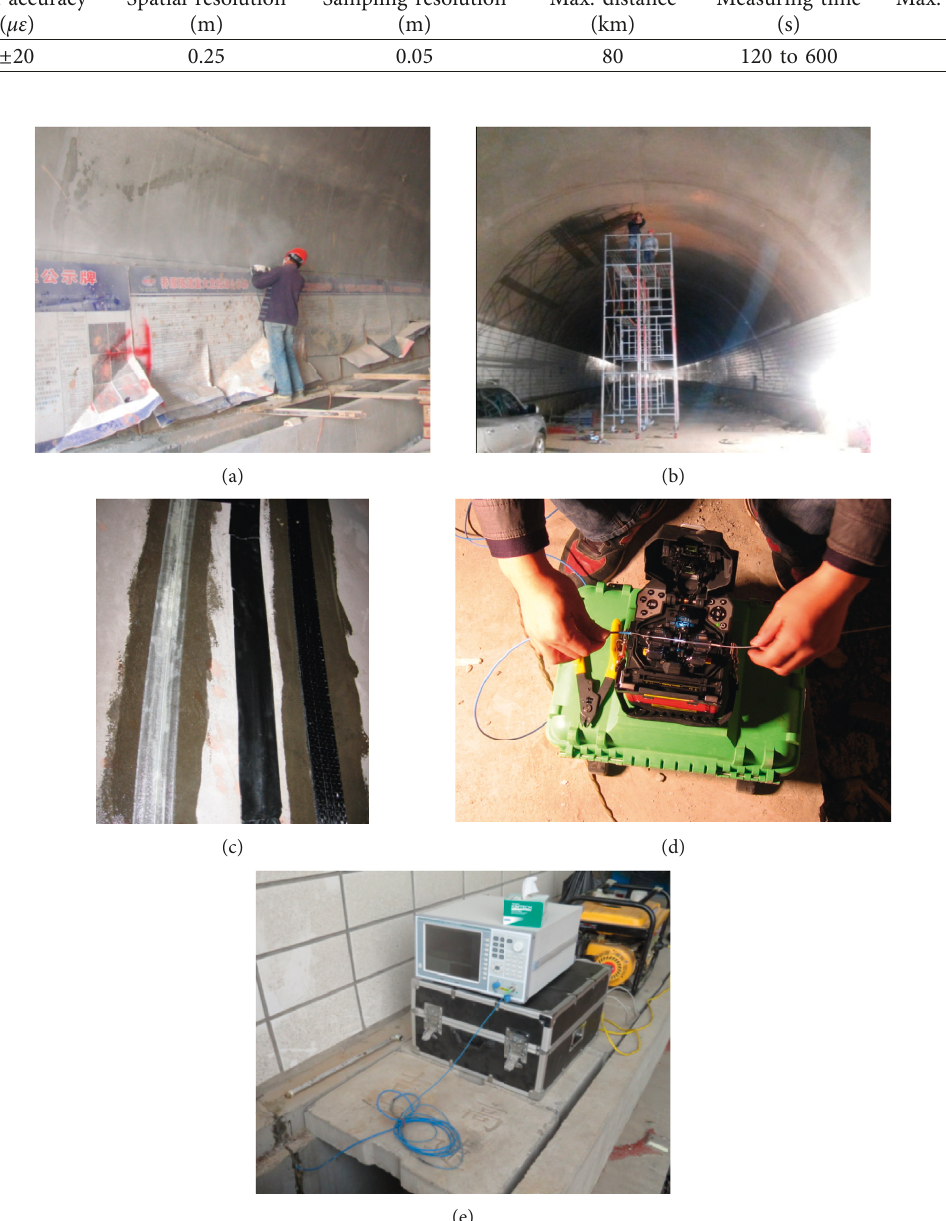
Figure 4: The distributed optical fiber installation flowchart: (a) carving slot and routing on the sidewall, (b) carving slot and routing on the crown, (c) laying of protection layer, (d) fiber splicing, and (e) debugging the light